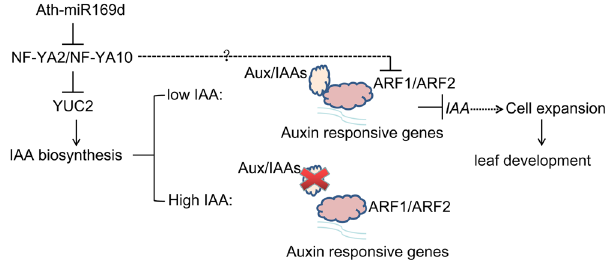
Figure 9. Schematic model of NF-YA2 and NF-YA10 mediated regulation of Arabidopsis leaf initiation and development through auxin signaling. IAA: indole-3-acetic acid; YUC2: YUCCA 2; ARF1: auxin response factor